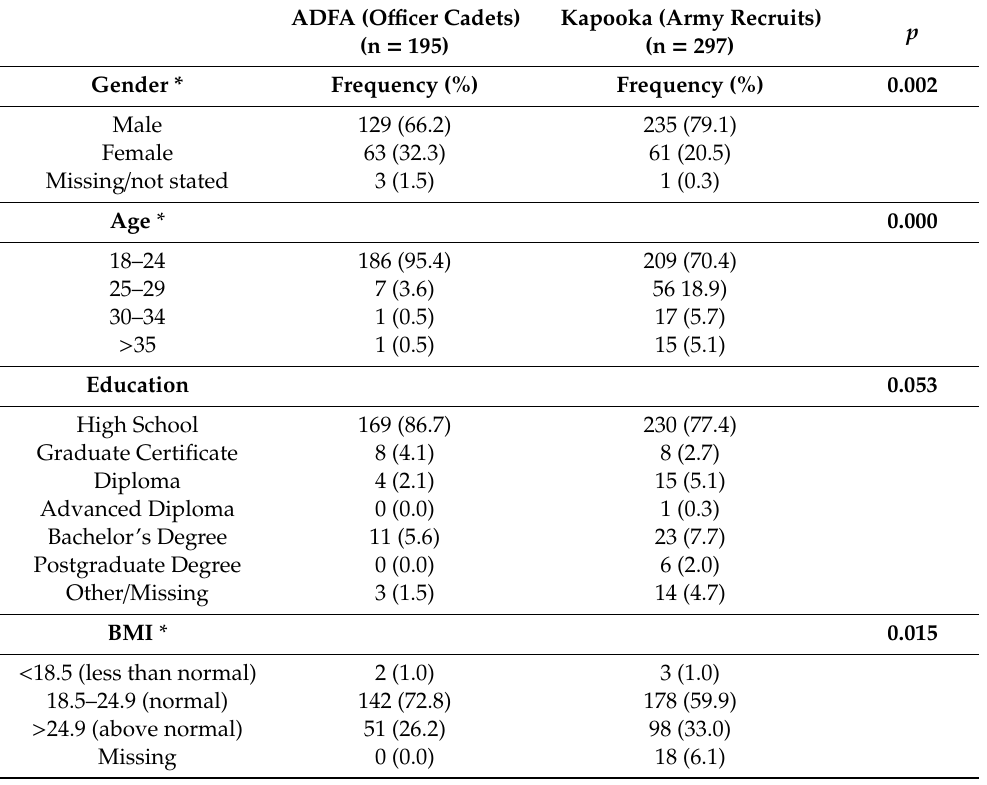
Table 1. Demographic profile of Australian Defence Force (ADF) trainees from two